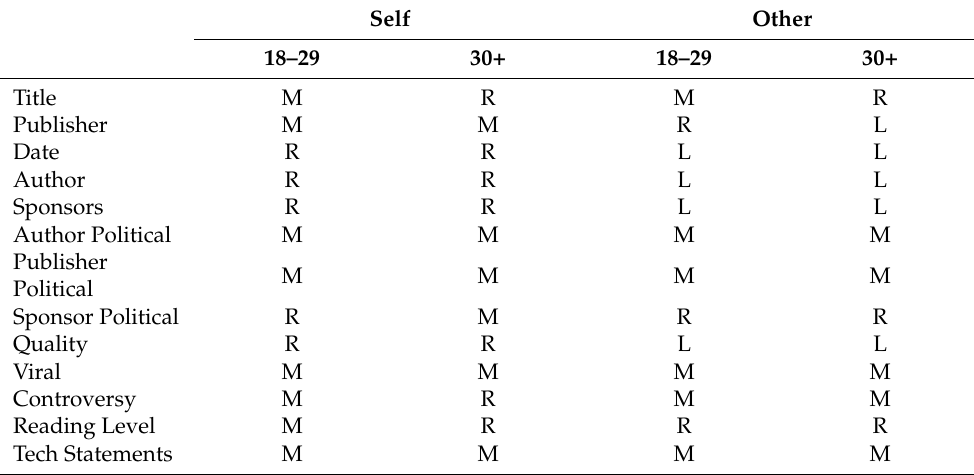
Table 6. Metrics with indication of a 10 percentage point difference between self and ideal perception or other and ideal perception by age group. ‘M’ indicates there is too much usage of this metric and ideally would be less. ‘L’ indicates there is too little usage of this metric and would ideally be more. ‘R’ indicates that the perception of real use is within 10 percentage points of the perception of ideal use for this